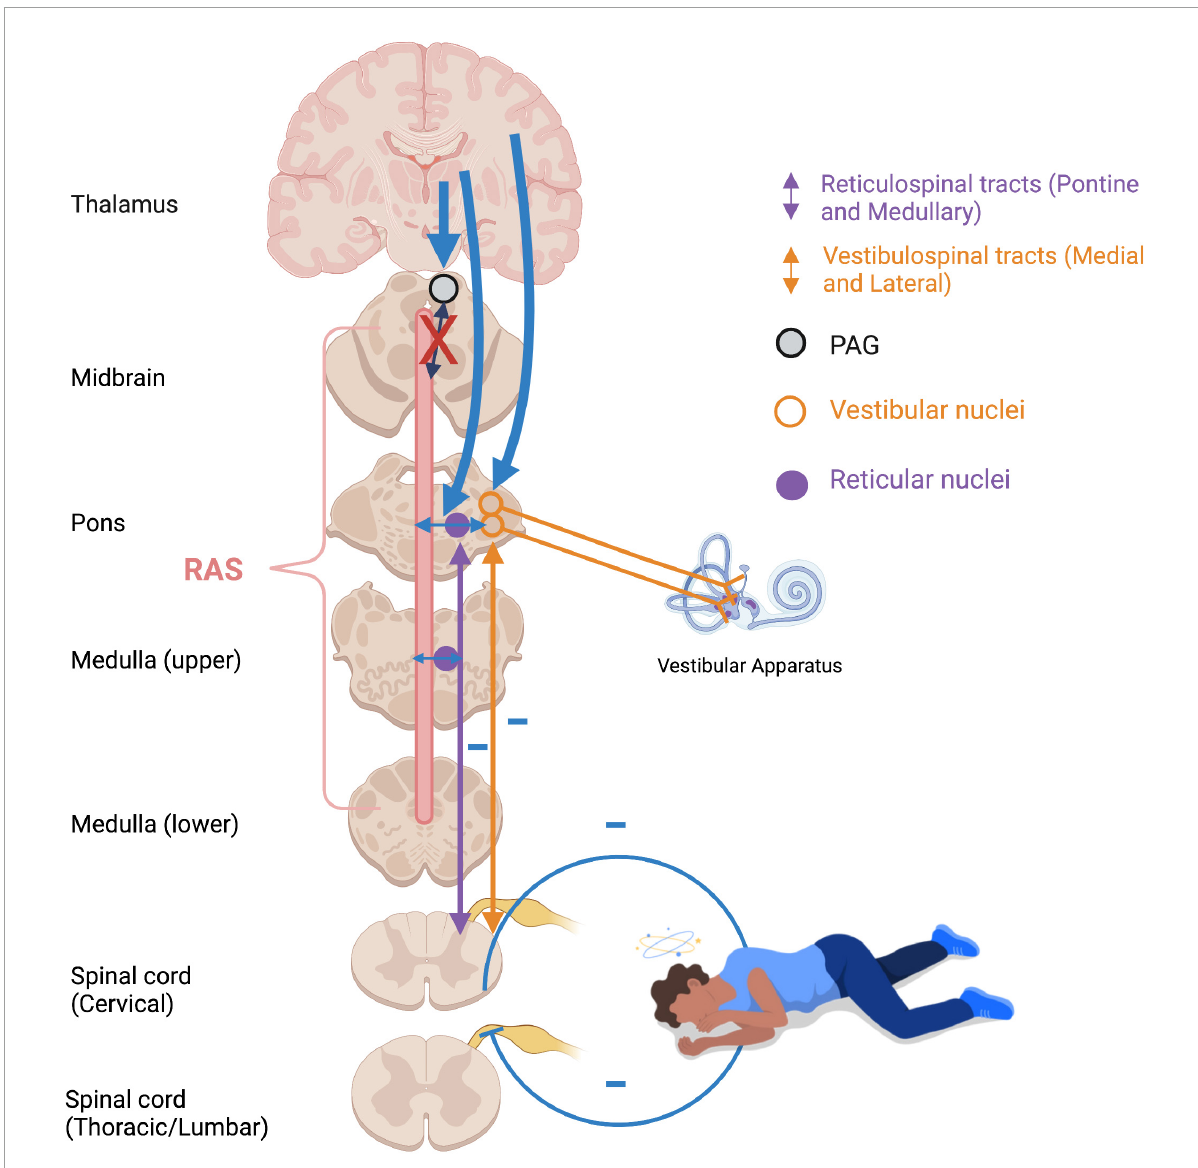
FIGURE7 Flaccidity of muscle tone during emotional shutdown/feign death/dissociative responses. Over-modulation of subcortical activation by higher structures (thick blue arrows) as an adaptive defensive response to repeated traumatic stress results in diminished arousal and weakened vestibular efferents to extensor musculature. Feedback from deafferented, flaccid muscles creates a somatosensory-vestibular feedback loop which subconsciously maintains a collapsed, dissociated posture and hypo-aroused state. RAS: reticular activating system; PAG: periaqueductal